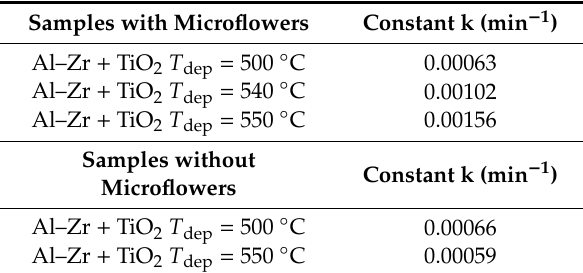
Figure 7. Evolution of the orange G degradation with UV light (371 nm) versus irradiation time for the TiO 2 /Al–Zr thin films deposited at (1 a ) 550°, (1 b ) 540 °C, (1 c ) 500 °C, with microflowers ( left ) and TiO 2 /Al–Zr thin films deposited at (2 a ) 500°, (2 b ) 550 °C without microflowers ( right ). The evolution of Al–Zr films are also presented on (1 d ) and (2 c ) for comparison. Table 1. Constant k (kinetic constant of the system) for TiO 2 / Al–Zr coatings deposited at different